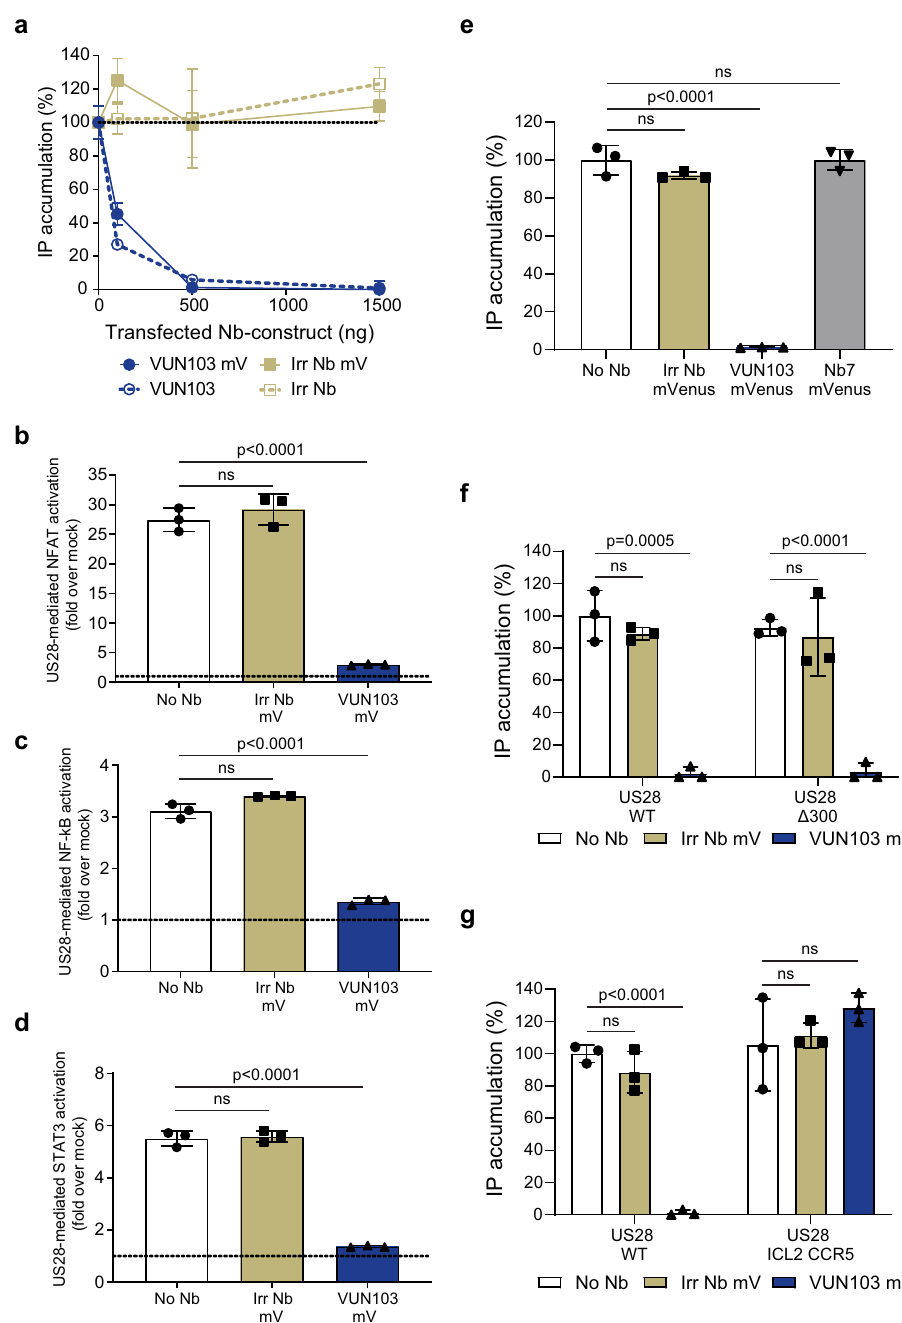
Fig. 2 VUN103 inhibits US28 signaling by binding to the ICL2 loop. a US28-mediated inositol phosphate (IP) accumulation of HEK293T cells